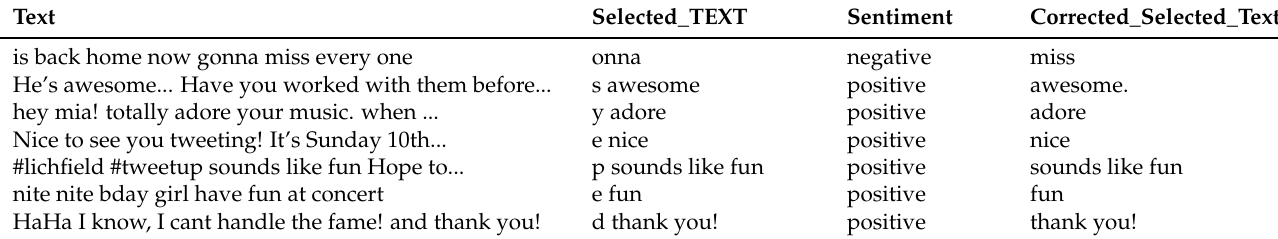
Table 5. Examples of incorrect and corrected selected text (right most column). selected_text and sentiment columns are manually labelled meta information which are corrupted due to special characters.